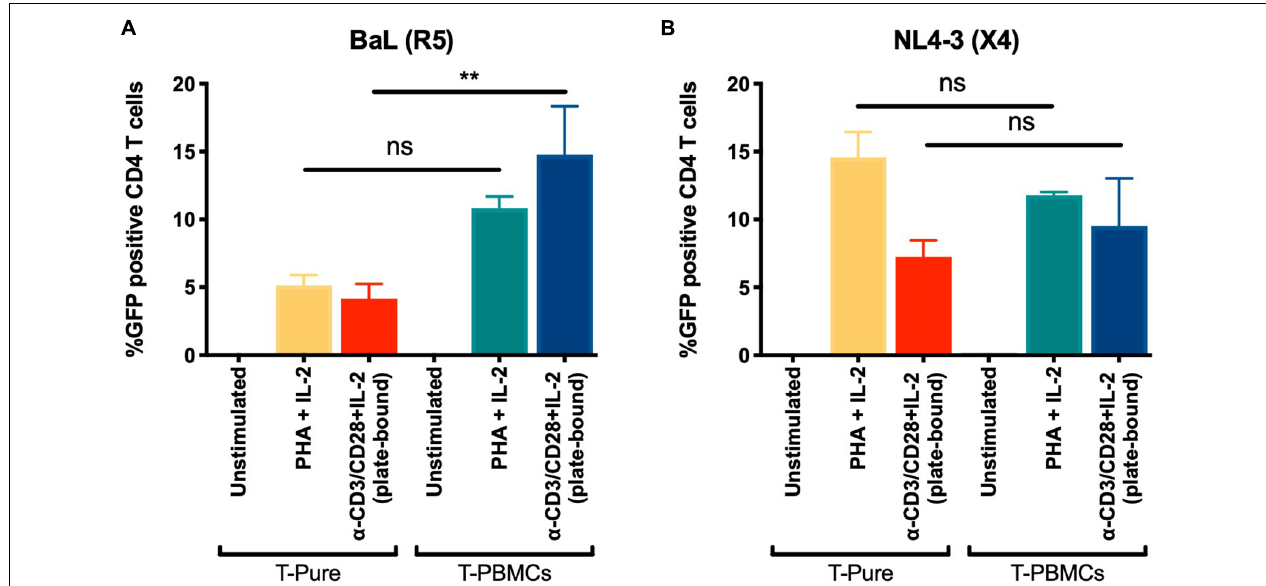
FIGURE 5 | Increased infection of T-PBMCs with an CCR5 tropic HIV-1. T-PBMCs and T-Pure cells were prepared as described in Figure 1B and infected with BaL (CCR5-tropic) (A) or NL4-3 (CXCR4-tropic) (B) GFP reporter viruses at a concentration of (100 ng/well p24). Two days later, the frequencies of infected (i.e., GFP+) CD3+ CD8- T cells was quantitated by flow cytometry. Bars correspond to mean ± SD ( n = 2 donors, each in triplicates). Statistical significance was calculated using One-way ANOVA with Tukey correction for multiple comparison. ** P < 0.01. ns, not significant.